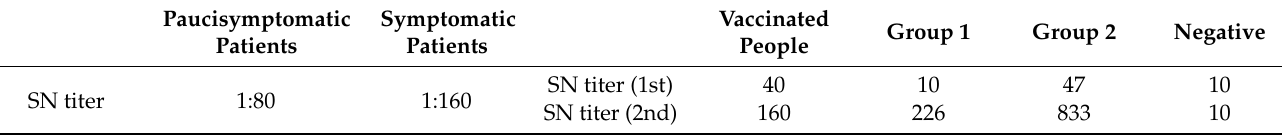
Table 3. Comparison table of serum virus neutralization test titer between the tested group, commer- cially available vaccine group, and paucisymptomatic or symptomatic patient group. Group 2 was found to have higher titers than the vaccinated people in both the first and second vaccination. Both Groups 1 and 2 were found to have higher titers than the symptomatic patients when the second vaccination was completed.